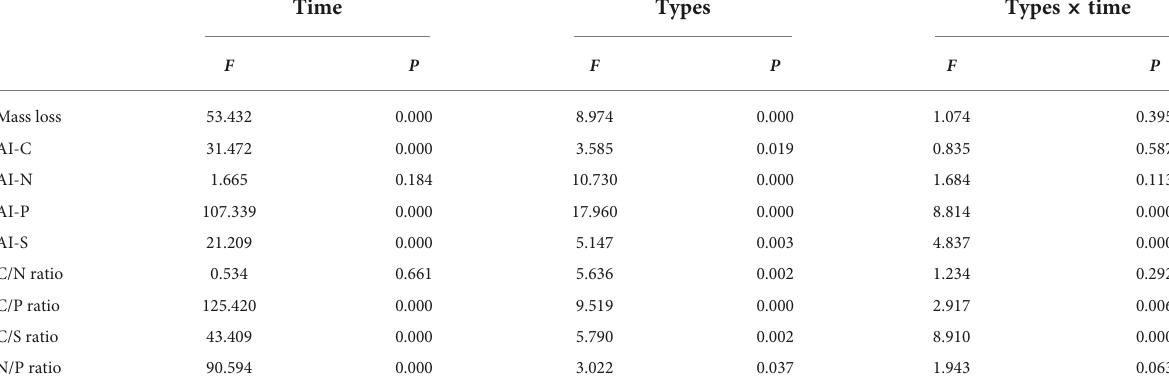
TABLE 1 Two-way analysis of variance (ANOVA) of mass loss, AI of selected elements, and elements mass ratio. Time Types Types × time